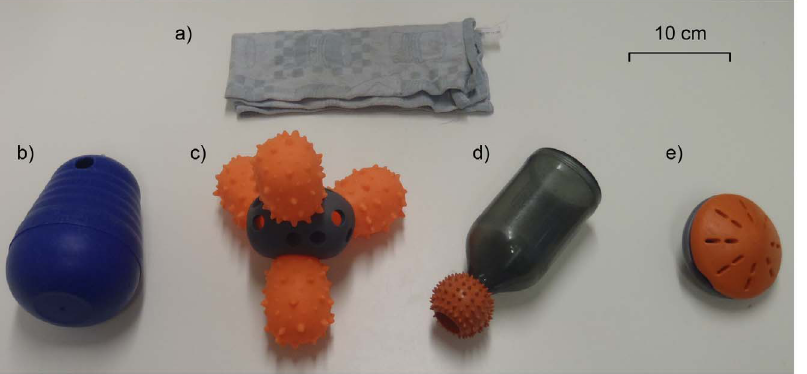
Figure 1. Apparatuses used in the experiment. a) Folded cotton towel used in the pre-test, b) Nina Ottosson (cid:2) Dog Pyramid (aDP), c) Hunter (cid:2) Snack Cactus (aSC), d) Hunter (cid:2) Snack Bottle (aSB), e) the smaller version of the Hunter (cid:2) Rolling Snack